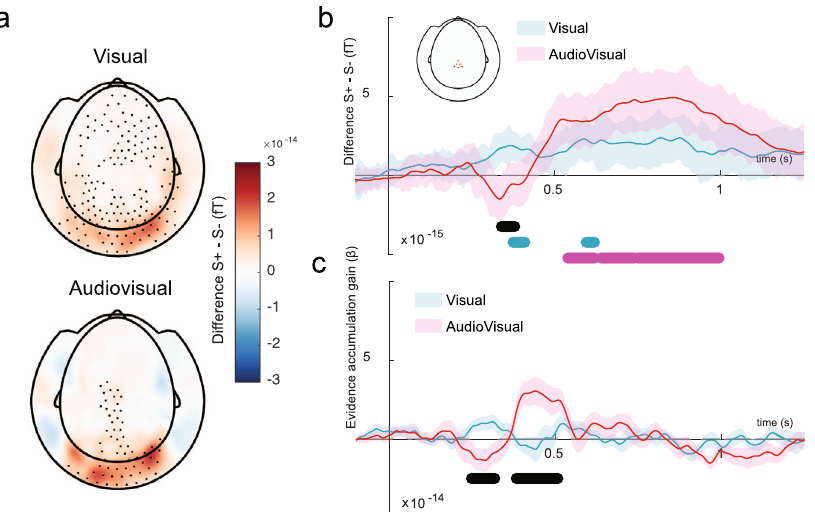
Fig. 5 Sounds boost the gain of post-sensory evidence accumulation. a Group-level difference difference between the sensor-level ERF activity in the signal-present and signal-absent conditions measured at ( a ) whole-brain scalp topography, and ( b ) centroparietal sensors (red points in the topography inset). c Evidence accumulation gain, measured as the slope of the differential ERF activity in B, as a function of time using a 200 ms sliding window. The black points in a depict those MEG sensors with signi fi cantly different activity in the S + and S − conditions. Line contours depict standard error. Magenta and green rectangles compress temporal clusters in which there are signi fi cant differences between the S + and S − conditions. Black rectangles depict temporal clusters in which there are signi fi cant differences between the audiovisual and visual timeseries. Group-level statistics were obtained using cluster-based permutation